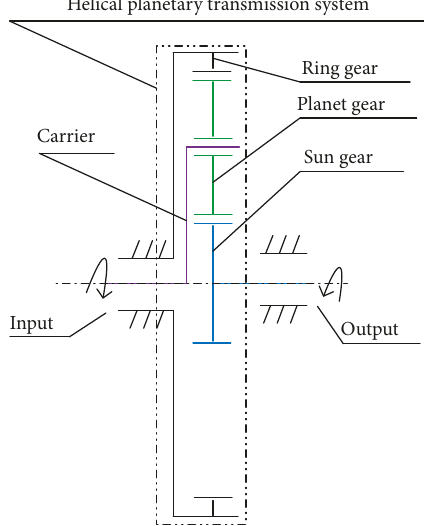
Figure 1: Structure and transmission principle of the HPTS. Table 1: Gear parameters of the HPTS.